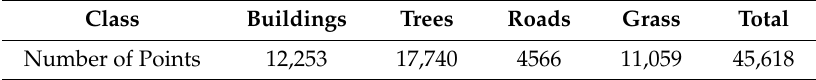
Table 2. Reference points for the four classes.